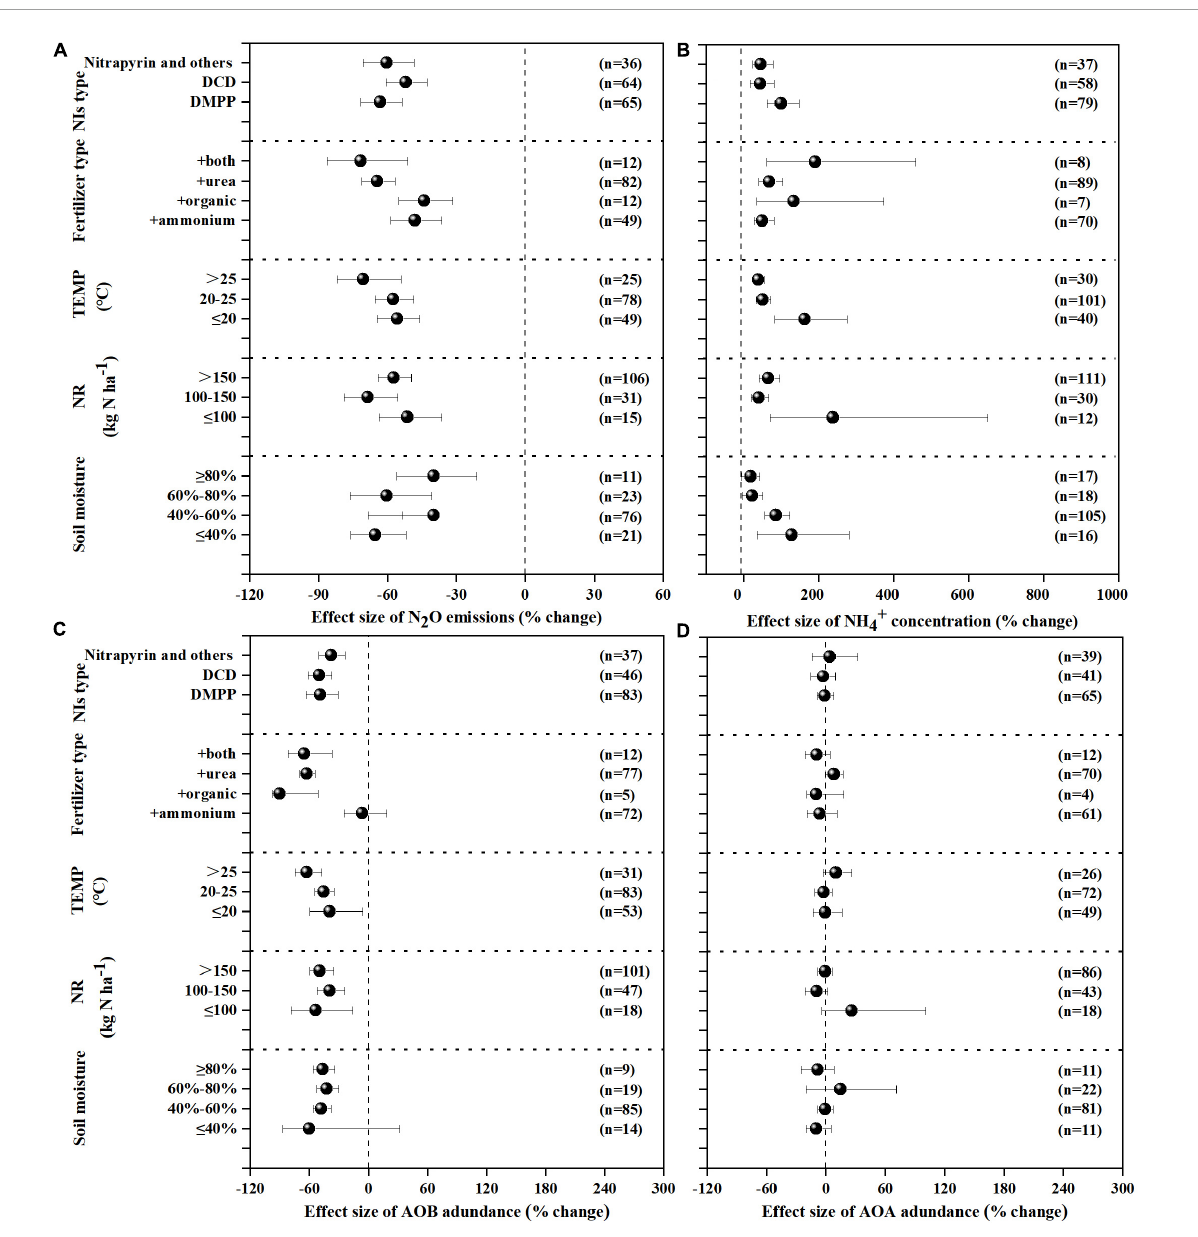
FIGURE3 Mean response ratios (% change) and bootstrapped 95% Confidence Intervals (CI) for the effects of experiment conditions on the response of